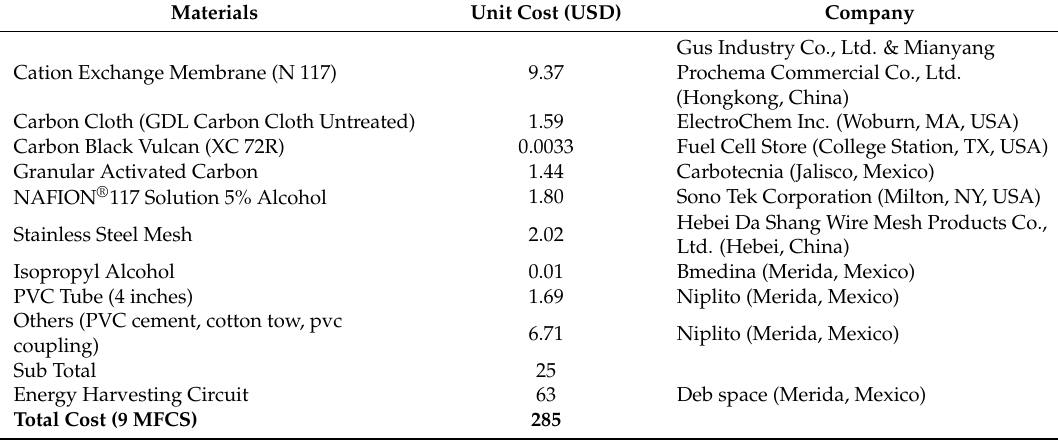
Table 4. Material cost for a MFC stack (9 cells) + energy-harvesting